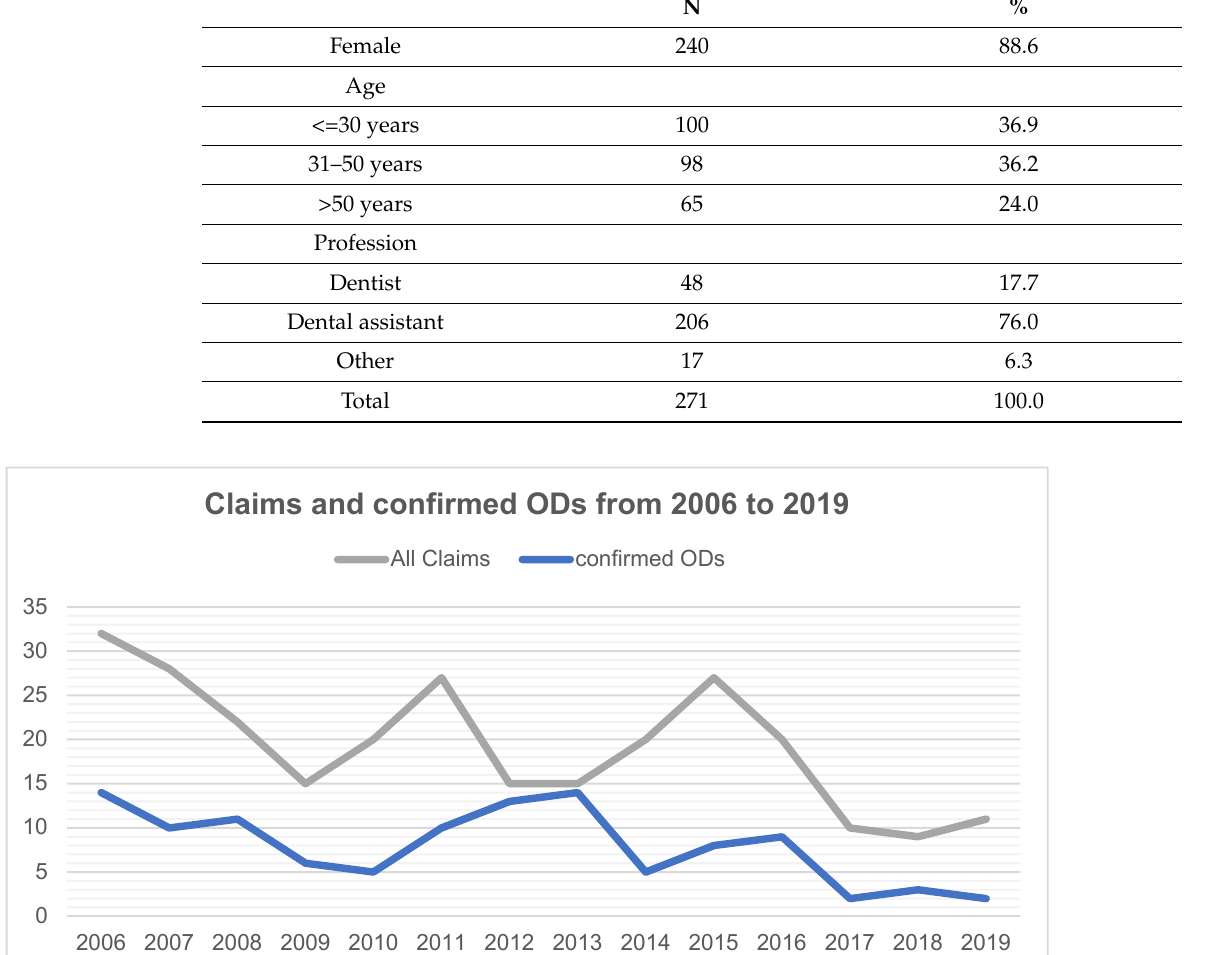
Table 1. Description of dental health workers (DHW) filing claims due to an infection from 2006 to 2019. Features of Population